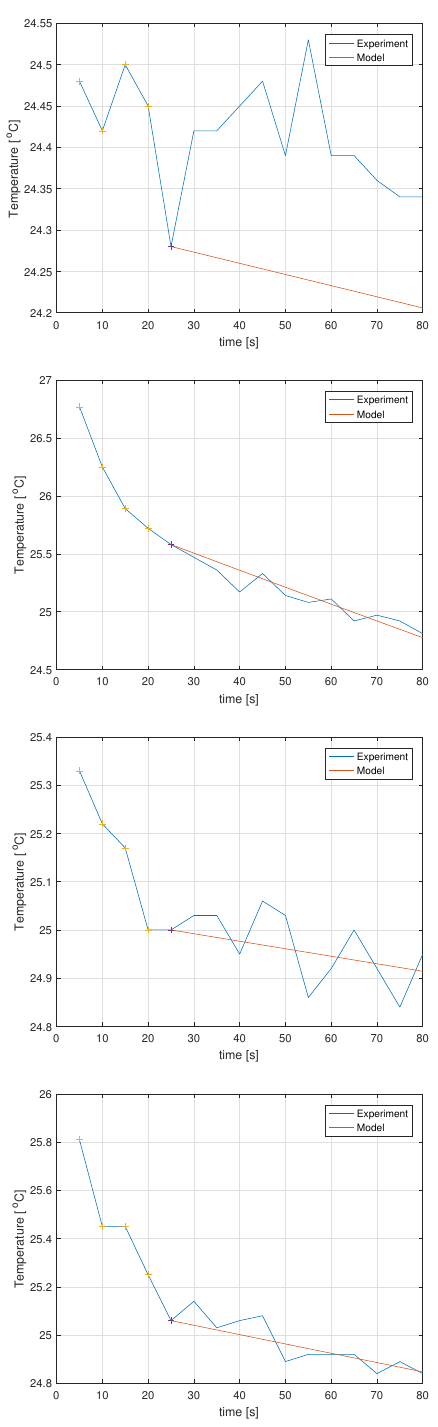
Figure 5. Comparison of responses of the IO model vs. the experiment for points (1— top )– (4— bottom